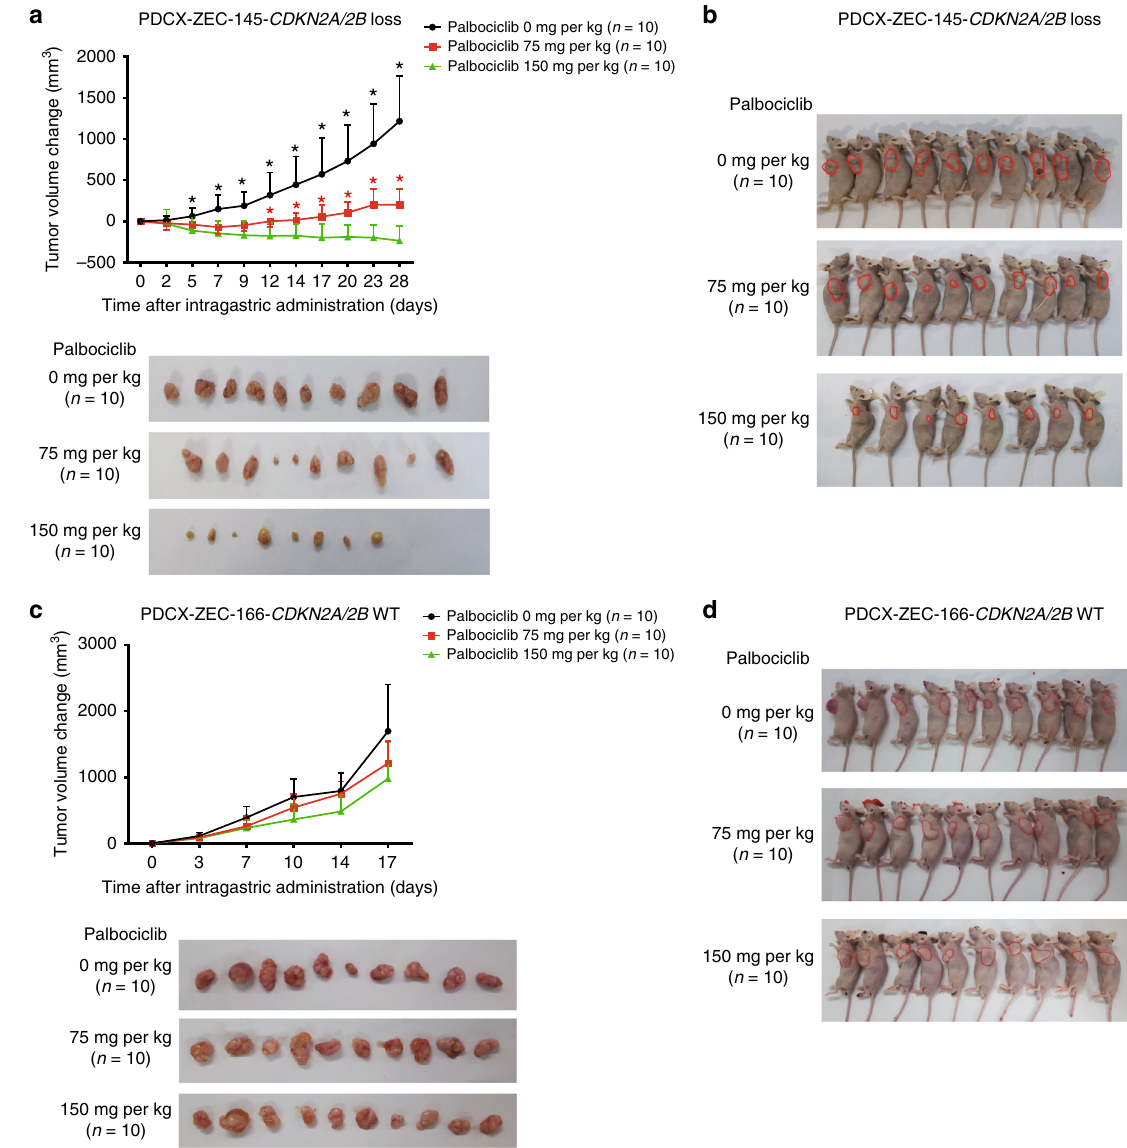
Fig. 5 Validation of the biomarkers of drug sensitivity in vivo. a , b Change in tumor volume following treatment with palbociclib at three doses in ZEC145 PDCX CDKN2A/2B loss tumors (28 days) and in ZEC166 PDCX CDKN2A/2B -WT tumors (17 days) (mean ± s.e.m., n = 10). c , d General picture of ZEC145 PDCXs and ZEC166 PDCXs after intragastric administration of palbociclib (10 mice per dose). Error bars correspond to standard error of the mean of tumor volume. * p < 0.01, Student ’ s t test, palbociclib 0 mg/kg compared with palbociclib 75 mg/kg; * p < 0.01, Student ’ s t test, palbociclib 75 mg/kg compared with palbociclib 150 Hospital. He had an operation on 23 June 2016. The hematoxylin and eosin (HE) staining of his FFPE tumor tissue was shown in Fig. 6a. He had current smoking status without alcohol intake, and he had no family history of malignant tumors. His tumor was from the distal esophagus. Based on the seventh edition of the American Joint Committee on Cancer (AJCC) staging system for esophageal cancer 31 , he was stage IIIb (Supplementary Data 18). Mutational pro fi ling was carried out by targeted deep sequencing (Supplementary Data 19) and showed that his tumor tissue harbored CDKN2A and CDKN2B loss. In addition, his tumor 6 inhibitor palbociclib than the PDCX models with wild-type tissue was negative for both p15 (coded by CDKN2B ) and p16 (coded by CDKN2A ) by immunohistochemistry (IHC) staining (Fig. 6b). Unfortunately, he died before he could start taking CDK4/6 inhibitors. However, a PDX model (Z16062301) was